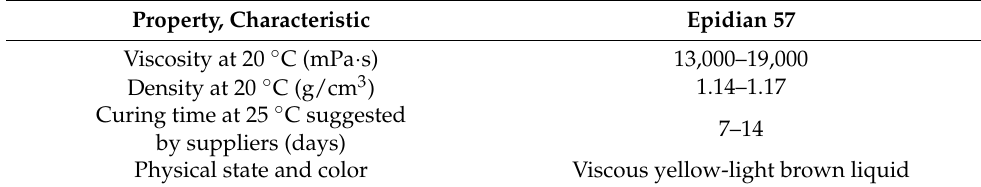
Table 1. Properties and characteristics of Epidian 57 epoxy resin.